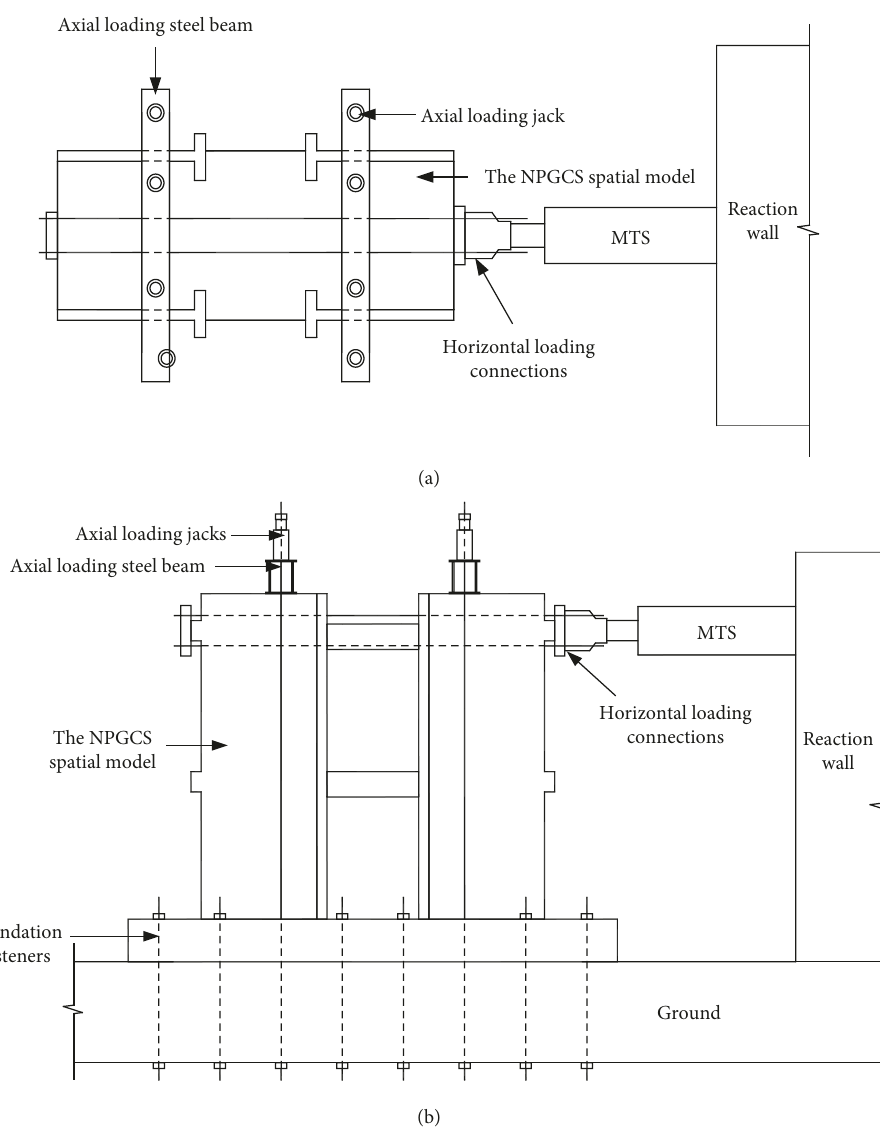
Figure 7: Experimental test setup. (a) Plan view. (b) Elevation